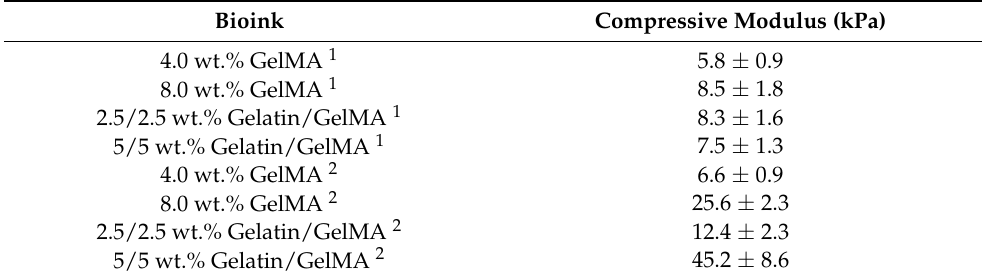
Table 3. Compressive modulus of the bioinks analyzed.